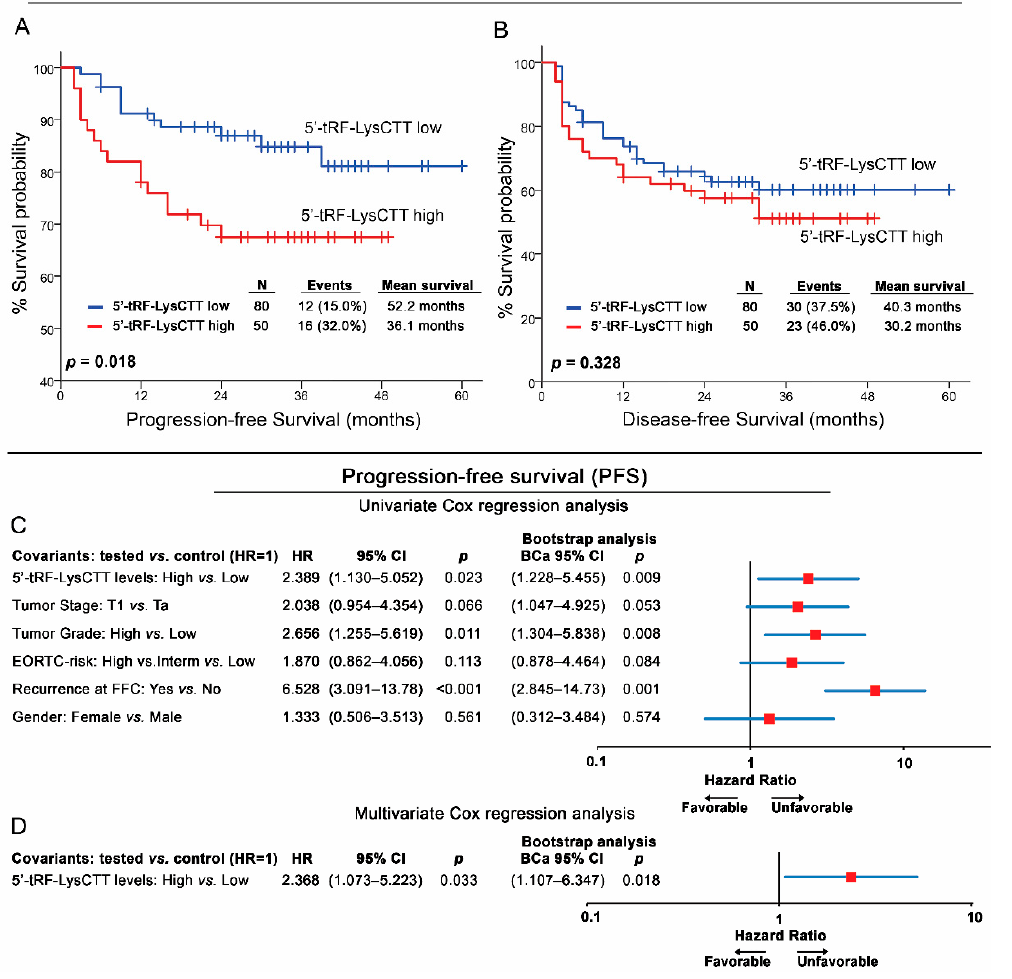
Figure 4. NMIBC (TaT1) patients with increased 5 ′ -tRF-LysCTT levels are at significantly higher risk for short-term progression to muscle-invasive disease. ( A , B ) Kaplan–Meier survival curves for the progression-free survival (PFS; ( A )) and the disease-free survival (DFS; ( B )) of the NMIBC (TaT1) patients according to 5 ′ -tRF-LysCTT levels. p -values calculated by log-rank test. ( C , D ) Forest plots of the univariate ( C ) and multivariate ( D ) Cox regression analysis for the NMIBC (TaT1) patients’ PFS. Multivariate analysis adjusted for 5 ′ -tRF-LysCTT levels, tumor stage, tumor grade, EORTC-risk stratification, recurrence at first follow-up cystoscopy and patients’ gender. Internal validation was performed by bootstrap Cox proportional regression analysis based on 1000 bootstrap samples. HR: Hazard Ratio, 95% CI: 95% confidence interval of the estimated HR, BCa 95% CI: bootstrap bias-corrected and accelerated 95% confidence interval of the estimated HR based on 1000 bootstrap samples.